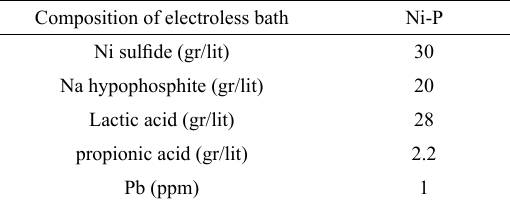
Table 2. Chemical composition of Ni-P electroless bath. Composition of electroless bath